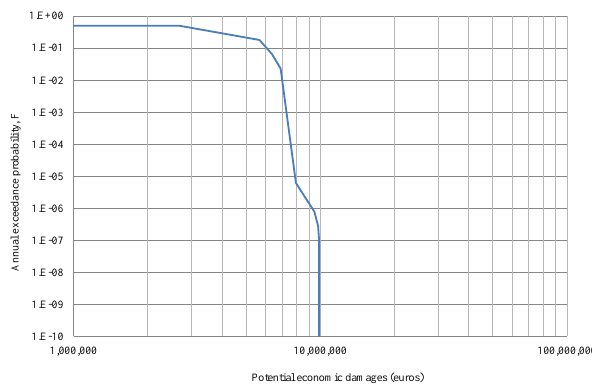
Fig. 10. FD-curve for the Base Case